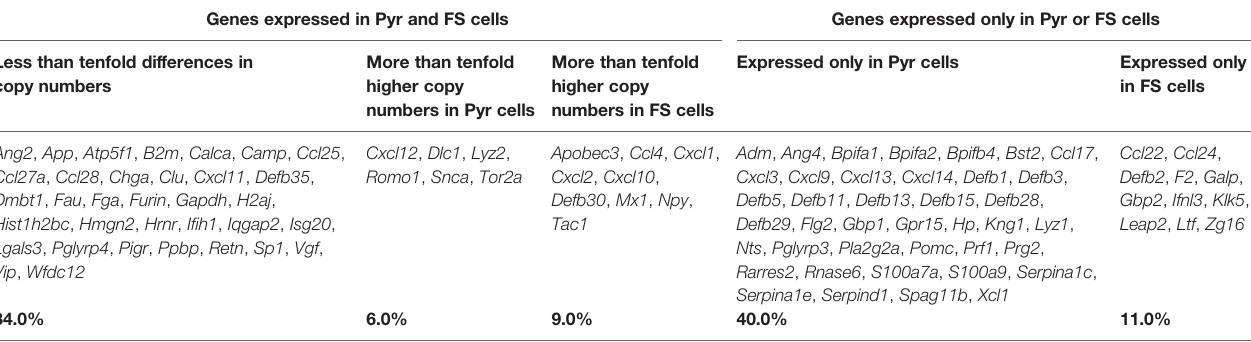
TABLE 1 | The distribution of AMP transcripts in the investigated Pyr and FS cells.